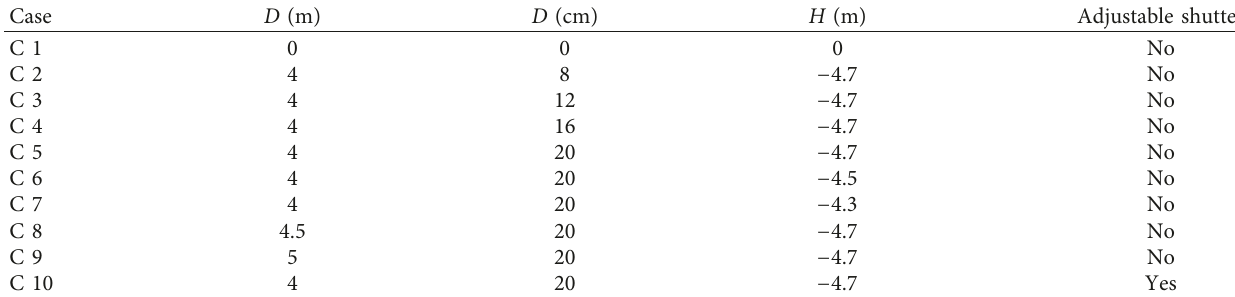
Figure 1: Illustration of the duct-ventilated tower footing. Table 1: Numerical simulation cases.